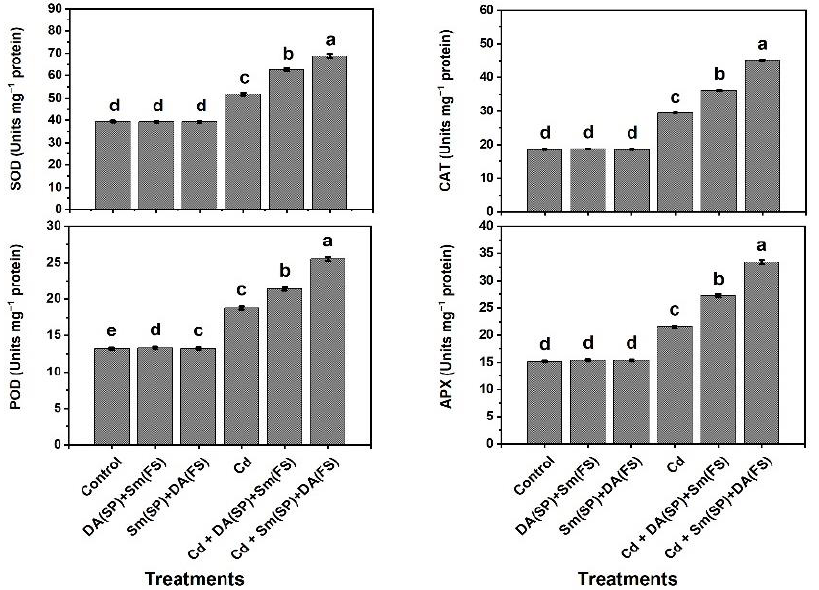
Figure 7. Effects of seed priming (SP) and foliar spraying (FS) with silymarin (Sm) or dopamine (DA) on enzymatic antioxidant activities of cadmium-stressed Phaseolus vulgaris plants. Columns labeled with same or different letters within each plot signify non-significant or significant differences, respectively, based on LSD test ( p ≤ 0.05). Bars represent SE values (three replicates). SOD = Superoxide dismutase, CAT = Catalase, POD = Peroxidase, APX = Ascorbate peroxidase. The contents of polyamines in terms of putrescine (Put), spermidine (Spd), and spermine (Spm), in addition to the polyamine metabolizing enzyme (ADC and ODC) ac- tivities, were significantly elevated under cadmium stress conditions by 113.6%, 35.5%, 32.6%, 54.8%, and 49.4%, respectively, while the level of PAO was markedly decreased by 27.5% relative to the control-grown plants (Figure 8). Both Sm or DA exogenous applica- tion (DA (SP) + Sm (FS)) and (Sm (SP) + DA (FS)) considerably increased Put, Spd, Spm, ADC, and ODC and significantly decreased PAO under cadmium-stress conditions, with a significant preference for silymarin seed priming + dopamine foliar spraying (Sm (SP) + DA (FS)), which increased Put, Spd, Spm, ADC, and ODC by 32.6%, 13.6%, 35.5%, 33.1%, and 34.6%, respectively, while decreasing the levels of PAO by 26.2% compared to un- treated plants (Figure 8).